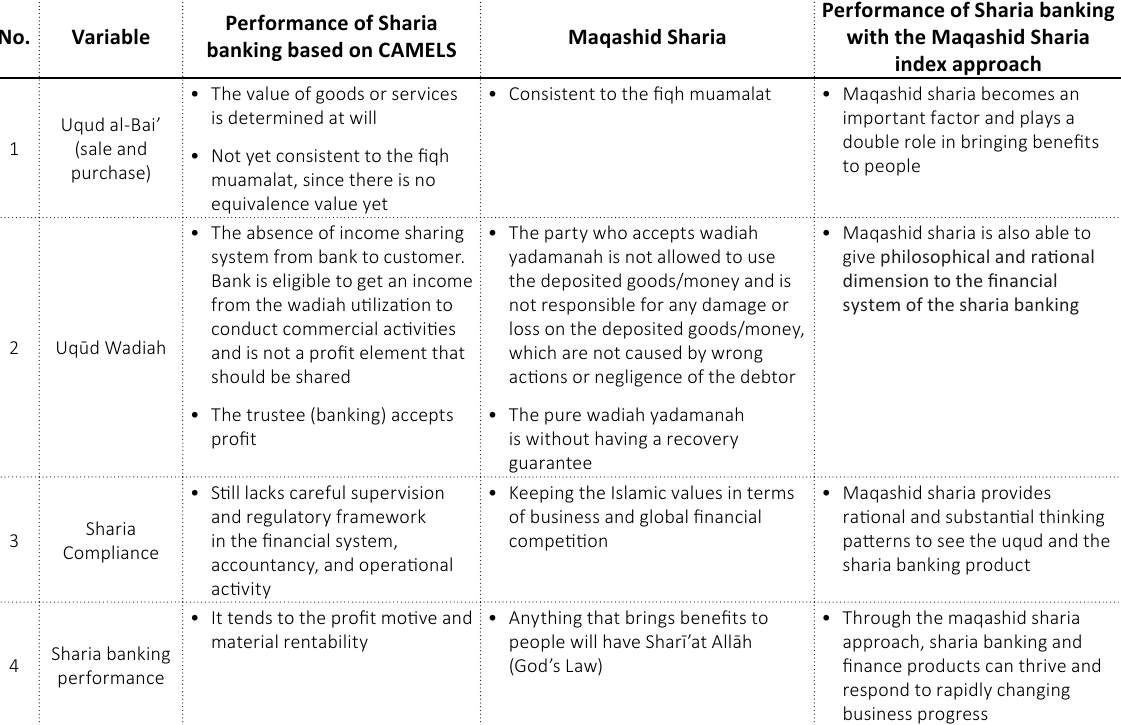
Table 4. Findings and research originality